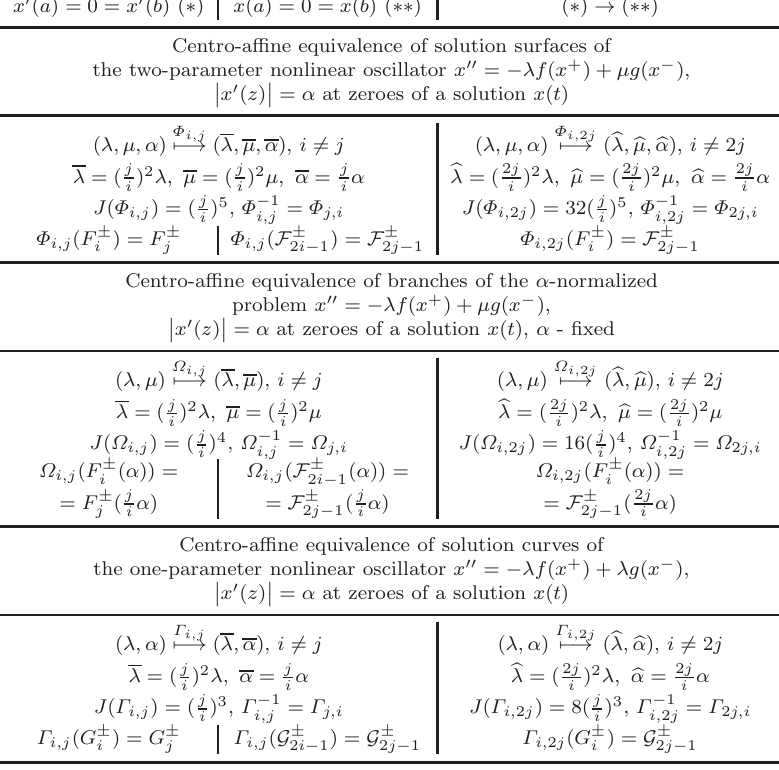
Table 1. Centro-affine equivalence formulae for the Neumann and Dirichlet BVP. x ′ ( a ) = 0 = x ′ ( b ) ( ∗ ) x ( a ) = 0 = x ( b ) ( ∗∗ ) ( ∗ ) → ( ∗∗